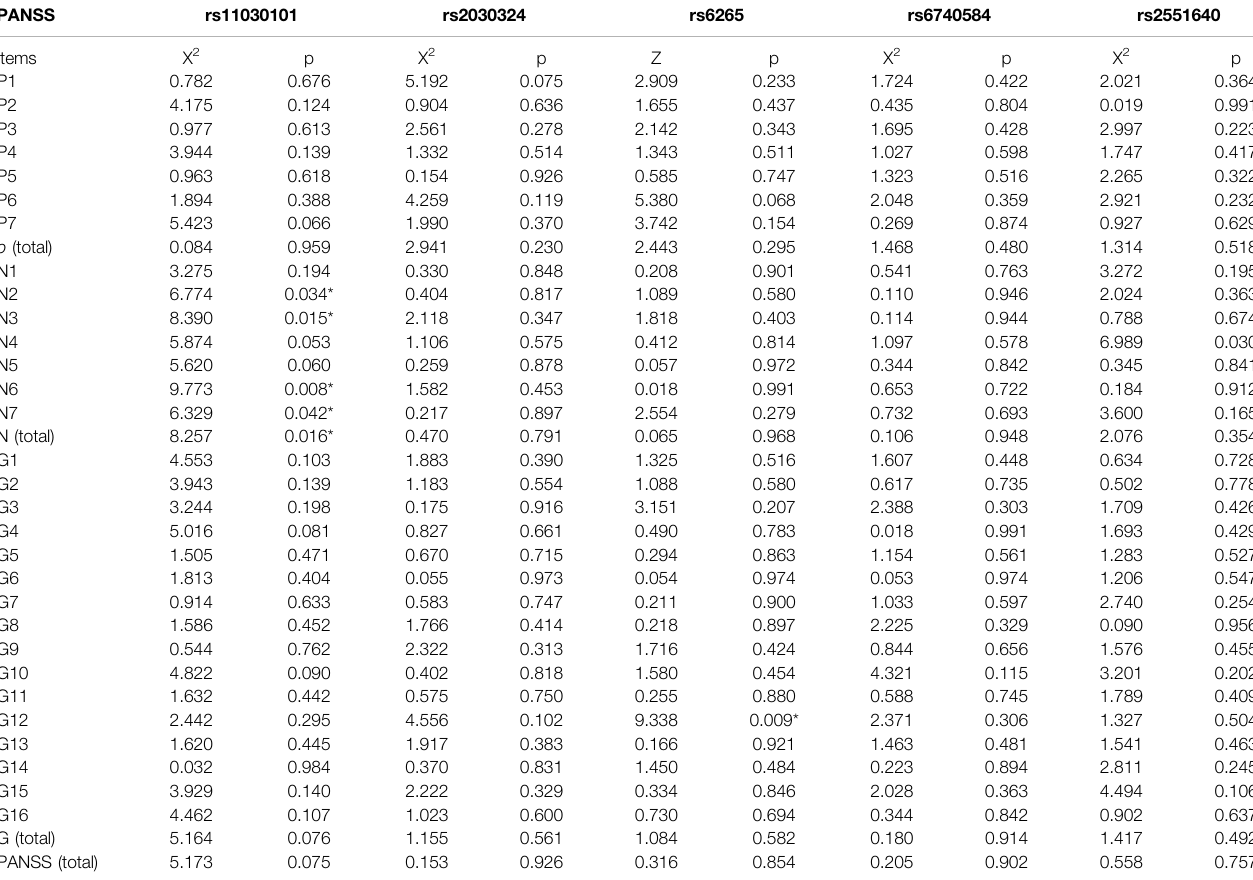
TABLE 9 | Relationships between different BDNF and CREB genotypes and PANSS scores in the schizophrenia group p < 0.05.